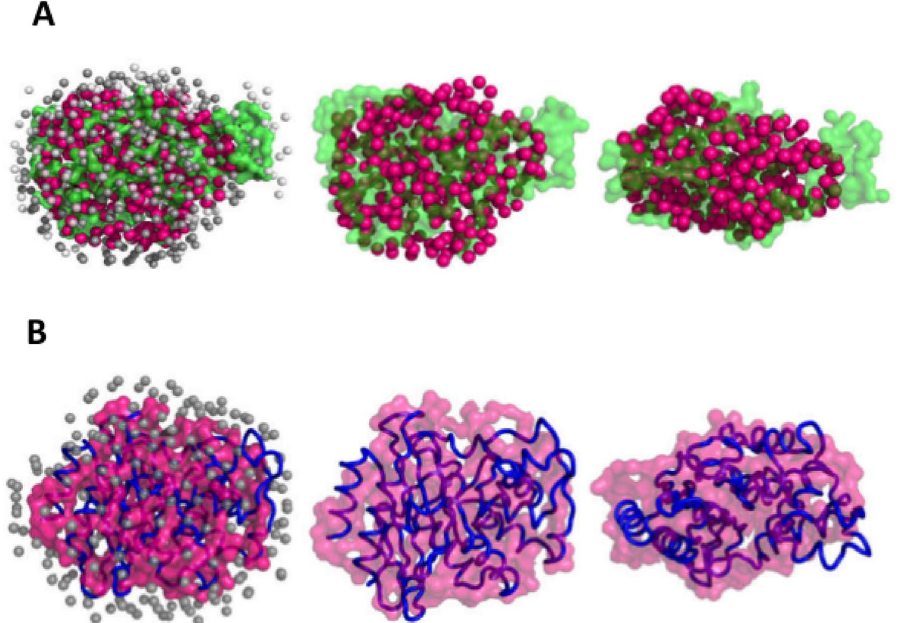
Figure 5. Modeling the closed shape of BlaC. ( A ) Starting from left, the SAXS model of BlaC in the presence of inhibitor C16 (Magenta) overlaid on the SAXS model of apo BlaC (green) followed by two orthogonal views of the overlaid models without the water molecules used in the structure reconstruction process, for clarity. ( B ) The SAXS model of BlaC in the presence of inhibitor C13 overlaid on the crystal structure (2GDN) followed by two orthogonal views without the water molecules (Left to